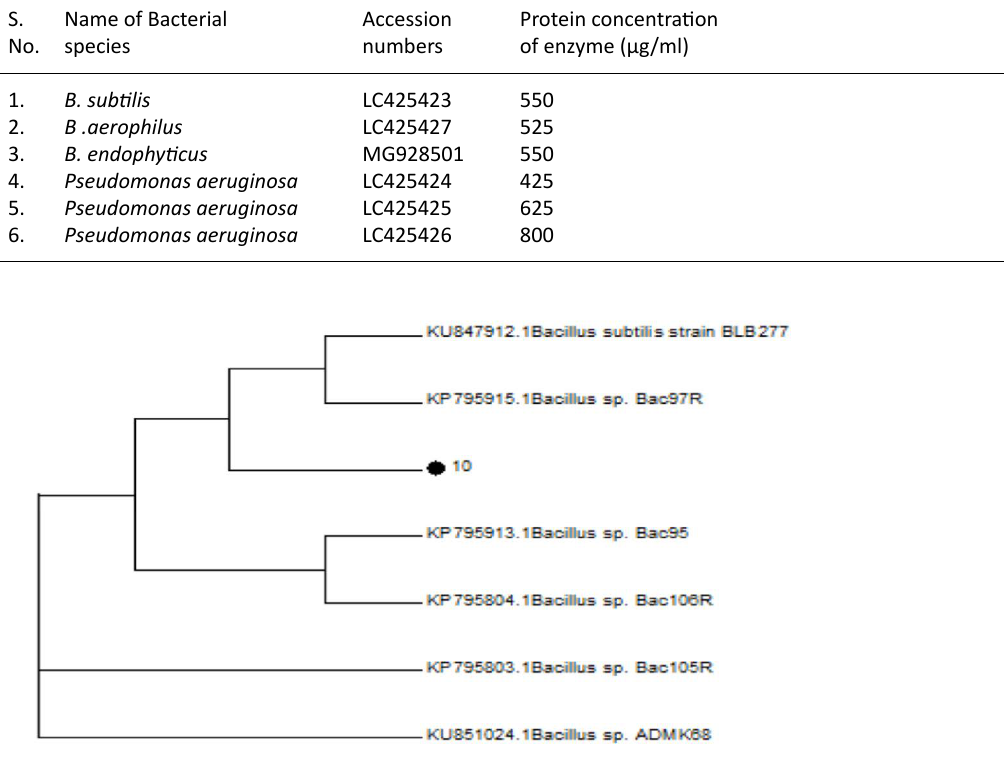
Table 3. Protein concentration of L asparaginase produced from Bacillus species and Pseudomonas aeruginosa